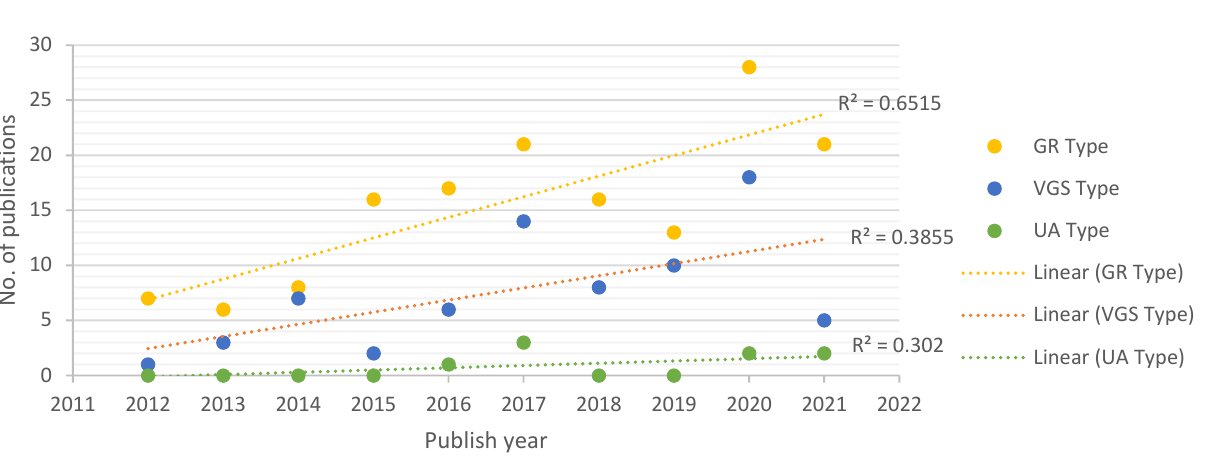
Figure 9. Distribution of the reviewed papers published between 2012 to 2021, according to their UGIB categories.